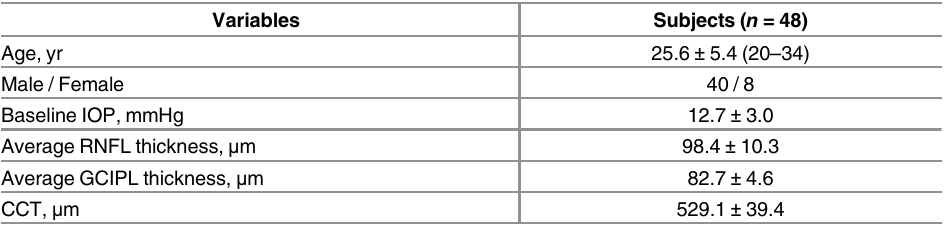
Table 1. Demographics of the